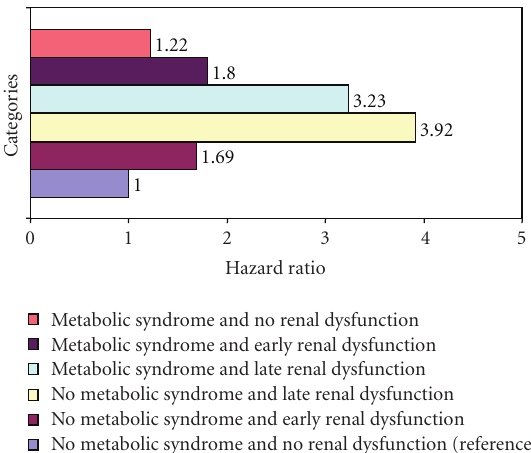
Figure 2: Bar chart: adjusted hazard ratios for cvd mortality versus categories of cocustered metabolic syndrome and renal dysfunction. OR for metabolic syndrome and no renal dysfunction not significant at P <